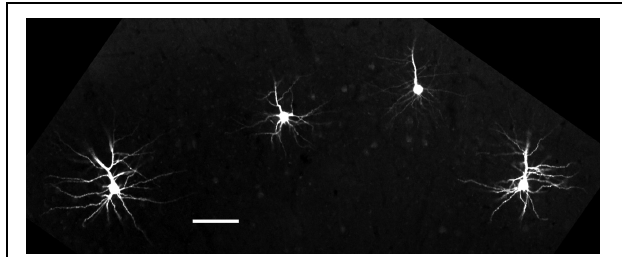
FIGURE 1 | Single cells microinjected with Alexa Fluor 594 dye. Neurons selected for filling were distributed across brain slices to maximize the total number of visible cells per slice while preventing overlap of dendrites. Scale bar = 100 µ